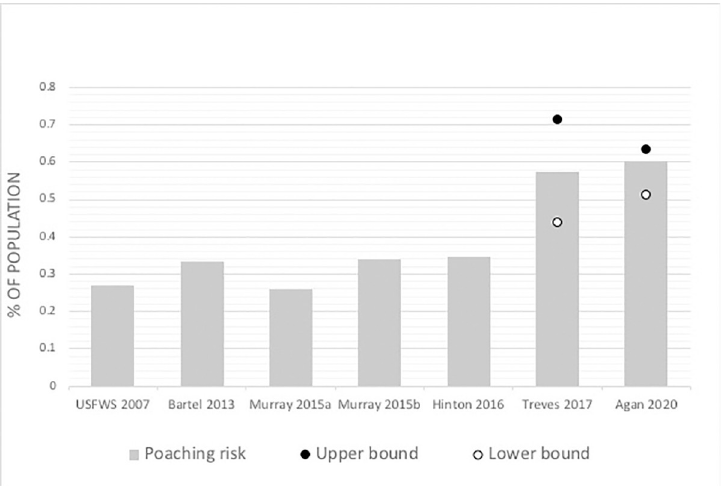
Fig 3. Risk of poaching estimated with different methods from overlapping but different samples of years of the NENC red wolf population. Treves [28] and this study presented 3 scenarios of cryptic poaching with a lower (open circle), middle (bar) and upper (closed circle) bound. Years of data vary by study [2, 10, 26,